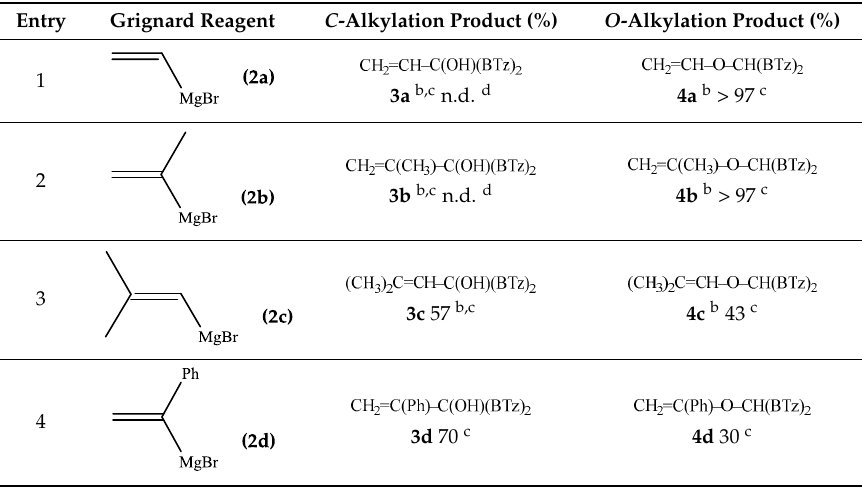
Table 1. Reaction of 1 with vinyl Grignard reagents 2a – h . a .